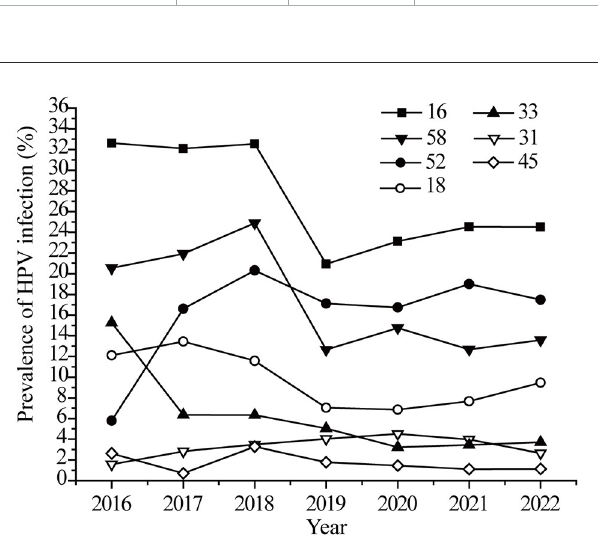
FIGURE3 The vaccines HPV prevalence in 7 years.